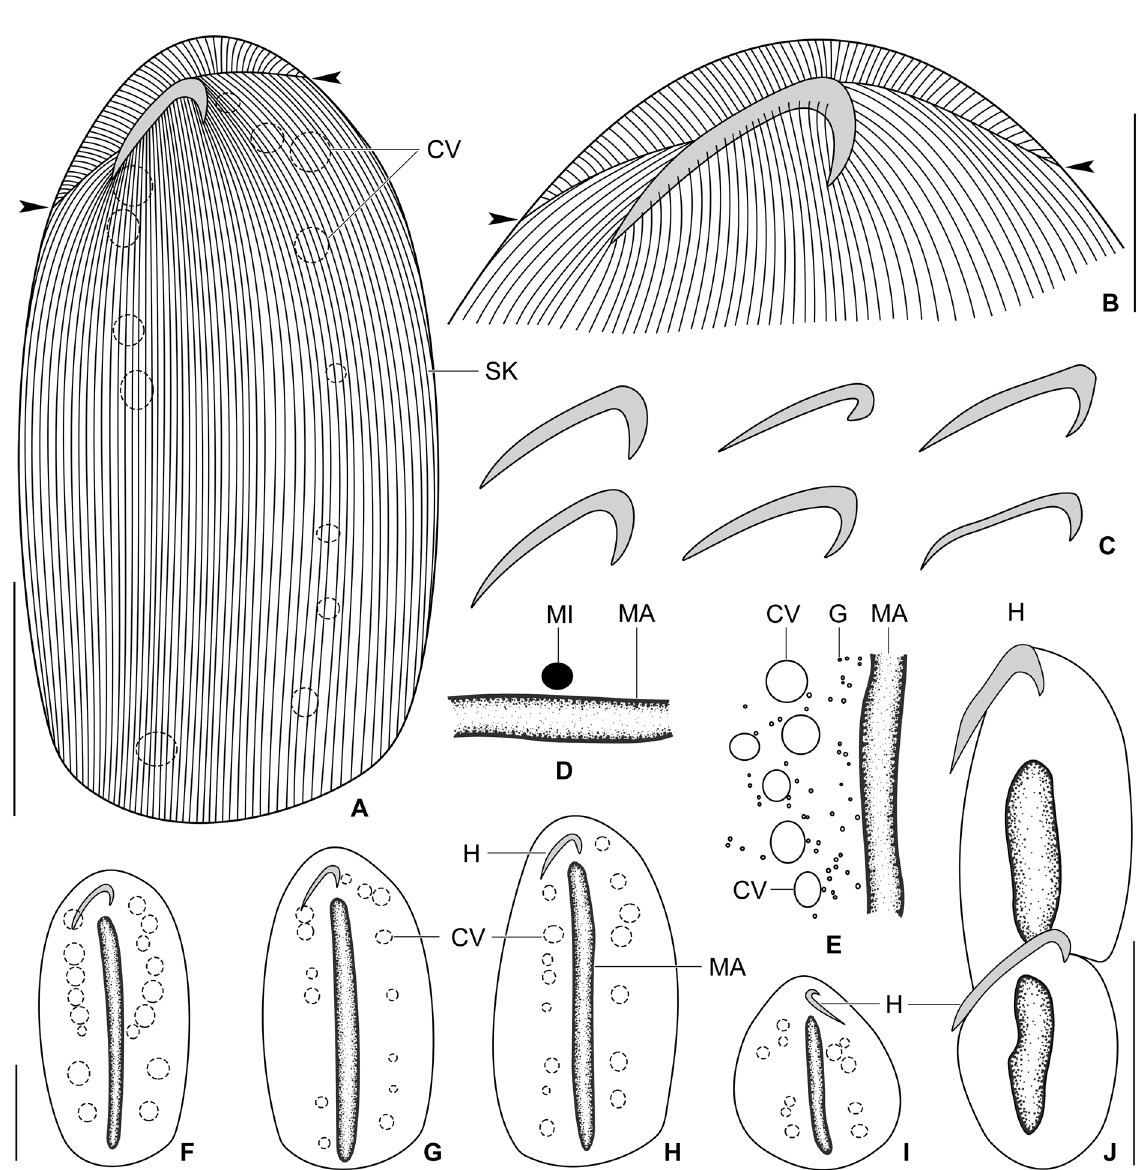
Fig. 6. Metaradiophrya varians (de Puytorac, 1954), Slovak specimens in vivo . A . Semi-schematic diagram of the ventral side, showing the localization of fibrillar hook, the arrangement of contractile vacuoles and the somatic ciliary pattern. Arrowheads mark the subapical suture extending from the right body margin over the fibrillar hook towards the left body margin. B . Detail of the anterior body portion, showing the fibrillar hook and its associated fibers. There are 5 or 6 fibers attached to the upper right side of the longer arm, on average 26 (22‒29) fibers to the ventral side of the longer arm and 11 or 12 fibers to the left side of the shorter arm. C . Shape variants of fibrillar hooks. The longer arm of the hook measures on average 30 µm, while the shorter arm only 11 µm. D–E . The macronucleus is rod- like and accompanied by an elliptical micronucleus. F‒I . Variability of body shape and size as well as of the contractile vacuole and nuclear apparatus. There are two staggered rows of contractile vacuoles arranged along the left and right side of the macronucleus. Drawn to scale. J . Ventral view, showing a late divider. Scale bars: A, F–J = 50 µm; B = 20